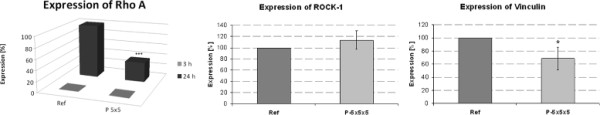
Densitometric analysis of the protein expression of Rho A, ROCK-1 and vinculin in MG-63 osteoblasts after 3 h (Rho A only) and 24 h. On the micro-pillared surface (P-5 × 5 × 5), Rho A expression is significantly lower compared to the planar reference (Ref). Vinculin expression is also lowered, ROCK-1 expression changes are not significant. (Mean ± SD, unpaired t-Test, n = 6 for Rho A, n = 3 for ROCK-1, *** p < 0.001) (Molecular Imager®; ChemiDoc™ XRS, Quantity One®; 1-D analysis software, Bio-Rad).